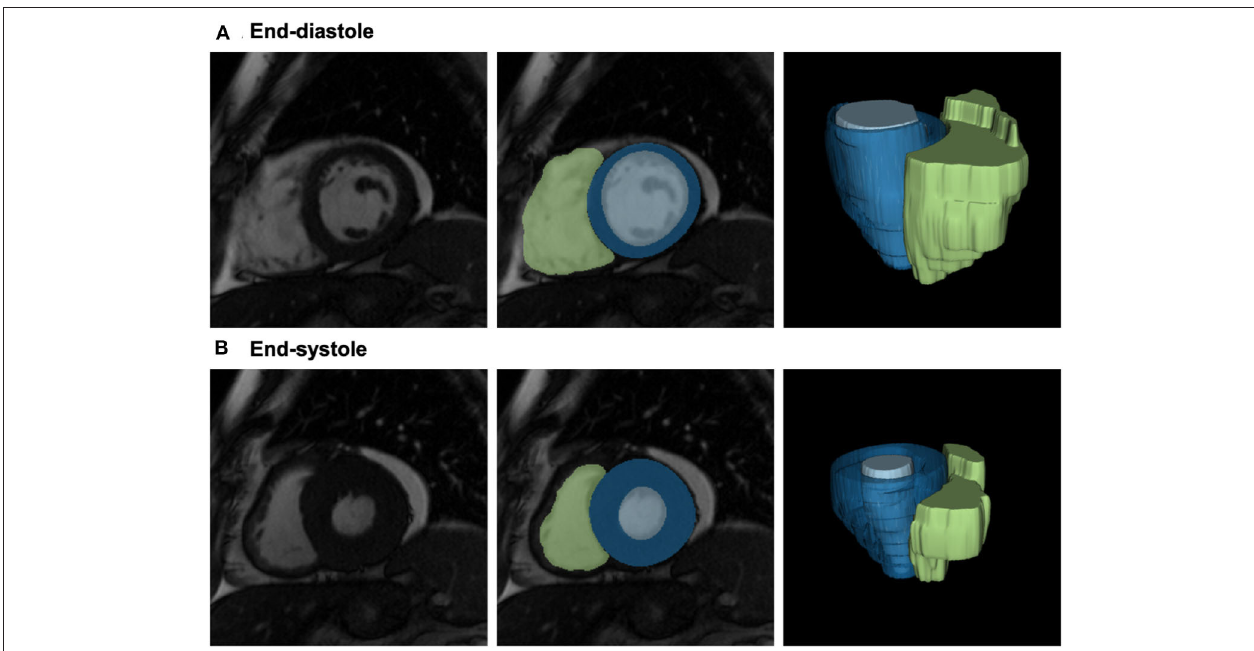
FIGURE 1 | Definition of the LV/RV blood pool and the LV myocardium for radiomics analysis. From left to right: 2D short axis mid-ventricular slice; segmentation of the three regions of interest shown overlaid on the image: LV myocardium (blue), LV blood pool (light blue), and RV blood pool (green); 3D reconstructions of the segmented ROIs. Please note, that radiomics analysis has been performed in 3D; 2D slices are provided for visualization purposes only. CMR: cardiac magnetic resonance; LV: left ventricle; ROI: region of interest; RV: right ventricle.